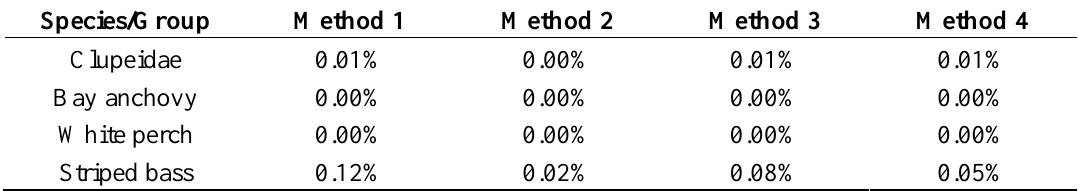
Table 6. Total number of equivalent adults lost annually as percentage of total equivalent adults available in the entrainable zone (average of flood and ebb